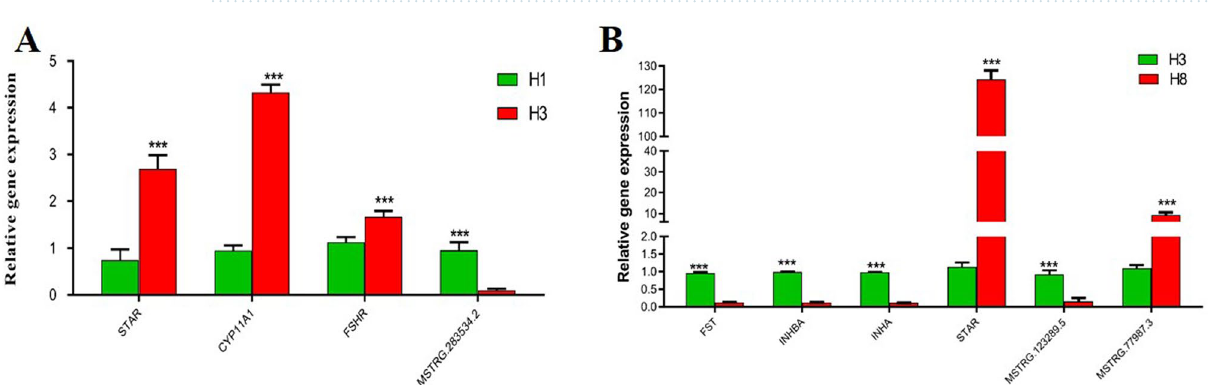
Figure 6. Relative expression of 10 selected differentially expressed genes. ( A ) Expression of 4 genes in H1 vs H8. ( B ) Expression of 6 genes in H3 vs H8. H1, H3 and H8 represent 1, 3 and 8 months old ovaries, respectively. The error bars represent the standard deviation. Bars with an asterisk (**) indicate significant difference by t test at 5%